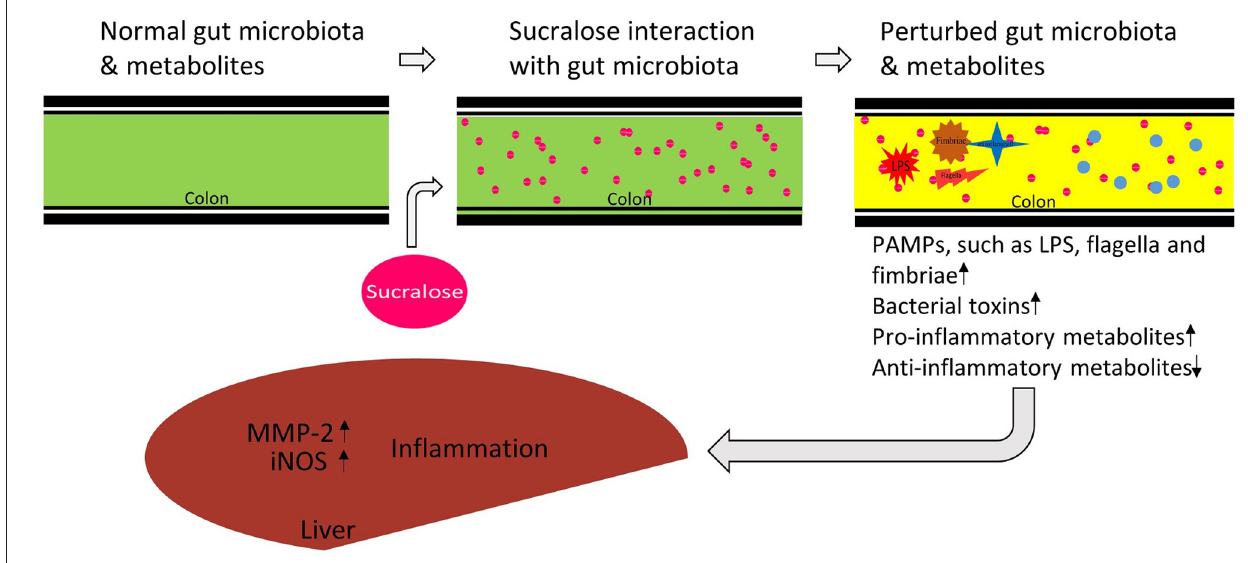
FIGURE 8 | Proposed functional link between sucralose-induced gut microbiota alterations and host inflammation. Sucralose perturbs the gut microbiome and its metabolic functions, inducing the enrichment of bacterial pro-inflammatory mediators, and disrupting metabolites involved in inflammation regulation. Together, these consequences may contribute to the induction of liver inflammation in the